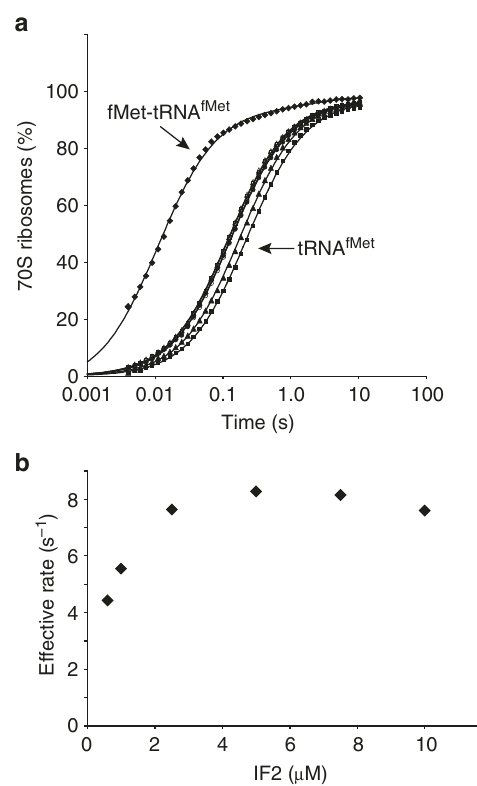
Fig. 4 Effect of IF2 concentration on the rate of 50S subunit joining to a pseudo 30S IC. a Ensemble kinetics of 70S IC formation after rapid mixing of 50S subunits with 30S IC wT assembled in the presence of 1 μ M wtIF2 or rates of 50S subunit joining to 30S IC wT,OH s containing increasing concentrations of